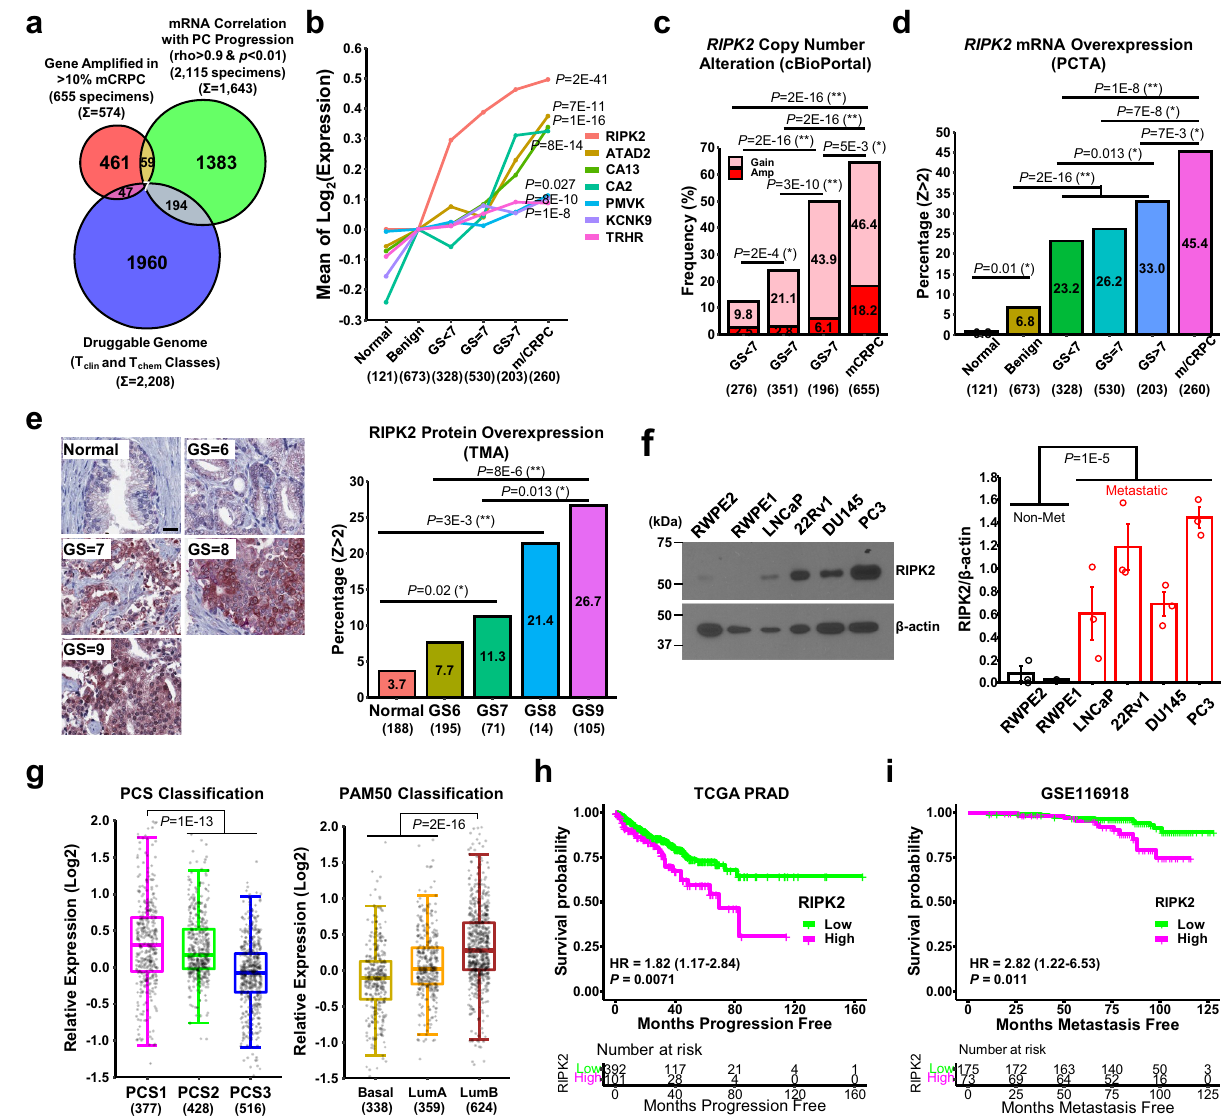
Fig. 1 RIPK2 is a top candidate druggable target for prostate cancer (PC) metastasis. a Venn diagram of human genes meeting the three indicated criteria. b mRNA level changes of the seven overlapping genes along with PC progression. GS: Gleason score. c Bar plot of frequencies of RIPK2 copy number ampli fi cation and gain along with PC progression. d Bar plot of frequencies of RIPK2 mRNA overexpression ( Z > 2 relative to tumor-adjacent normal tissue) along with PC progression. PCTA: Prostate Cancer Transcriptome Atlas. e Comparison of RIPK2 protein expression levels in primary PC. Left panel: representative IHC images (scale bar = 25 µ m). Right panel: frequencies of RIPK2 protein overexpression ( Z > 2 relative to tumor-adjacent normal tissue) along with PC progression. TMA: Tissue microarray. f Comparison of RIPK2 protein levels in six commonly used prostate cell line models. Left panel: representative immunoblotting images. Right panel: bar plot of relative RIPK2 protein abundance normalized against β -actin ( n = 3 biologically independent samples per group). Non-met: non-metastatic. g Box plots of RIPK2 mRNA levels in three PCS (left) and PAM50 (right) subtypes of prostate tumors in the PCTA cohort. Box plots indicate median (middle line), 25th and 75th percentile (box), and 5th and 95th percentile (whiskers). PCS: prostate cancer subtype; PAM50: prediction analysis of microarray 50. h Kaplan – Meier progression-free survival analysis of PC patients in the TCGA PanCancer